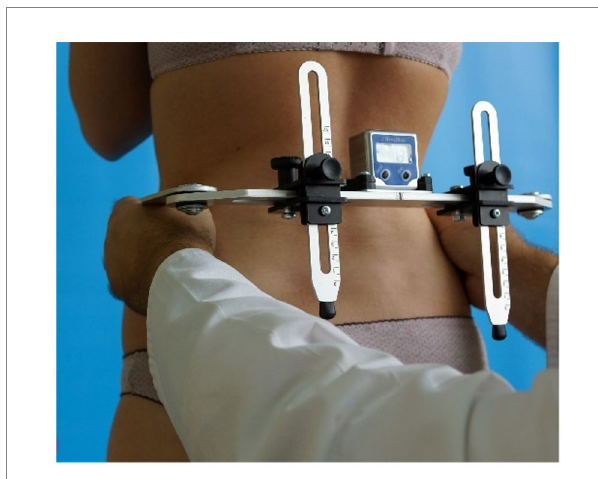
FIGURE 1 Measurement of iliac crest angle using Duometer (own source).